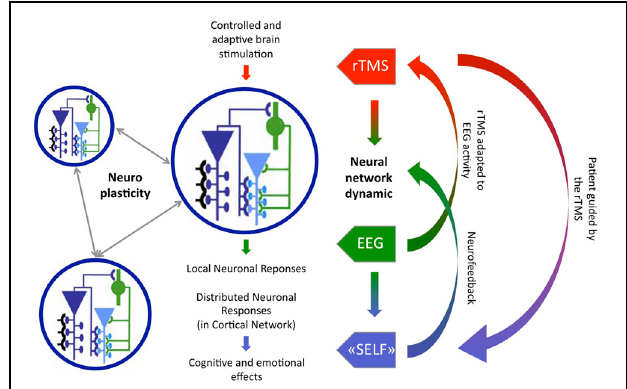
FIGURE 1 | Combination of Brain-State-Dependent Stimulation (green-red loop) and Neurofeedback rTMS (blue-red loop) as an example of Cyborg psychiatry device, adapted from Thut and Pascual-Leone